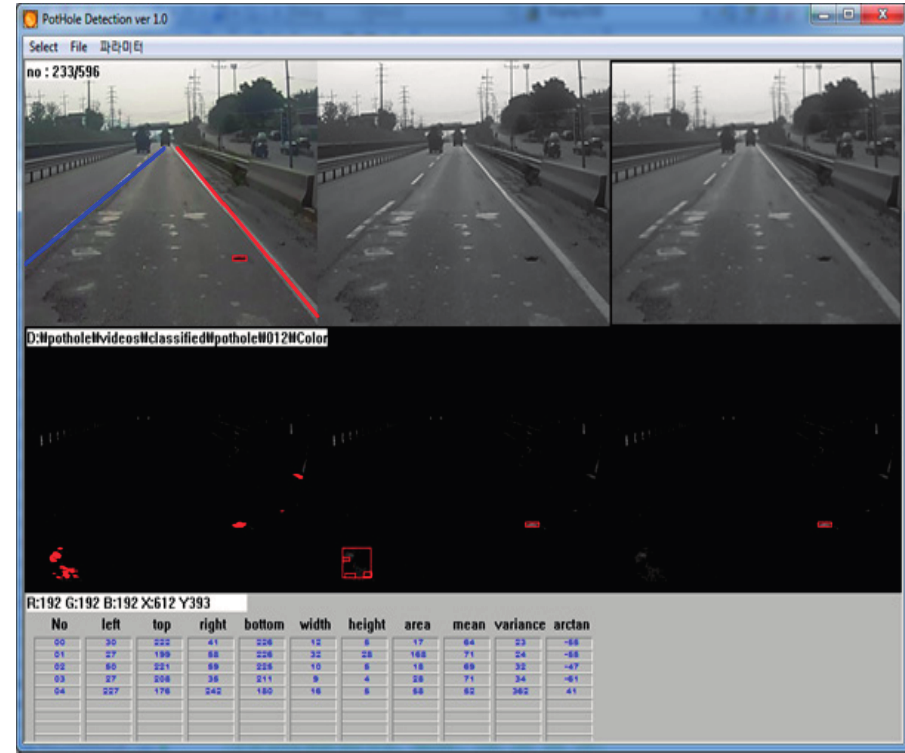
Figure 12. Simulation software for pothole detection.